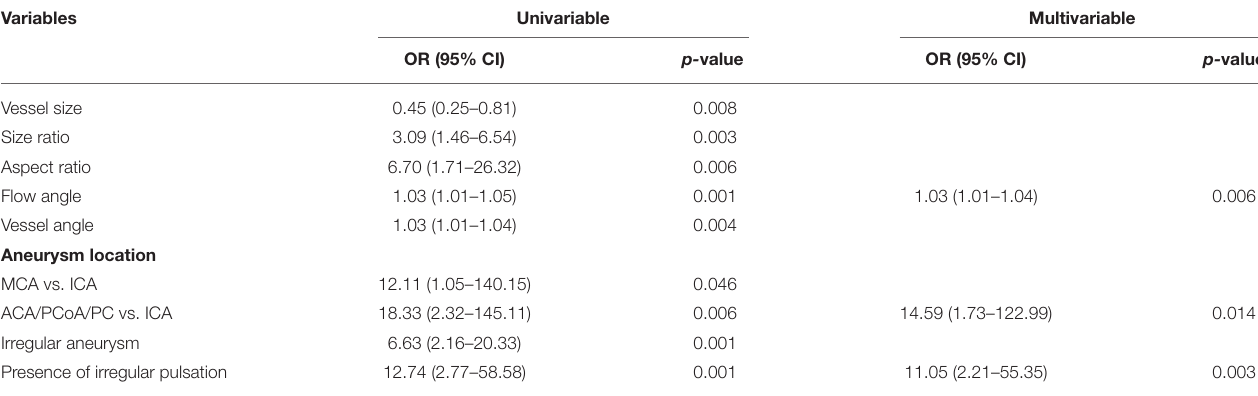
TABLE 4 | Univariate and multivariate analyses of predictors of small aneurysm